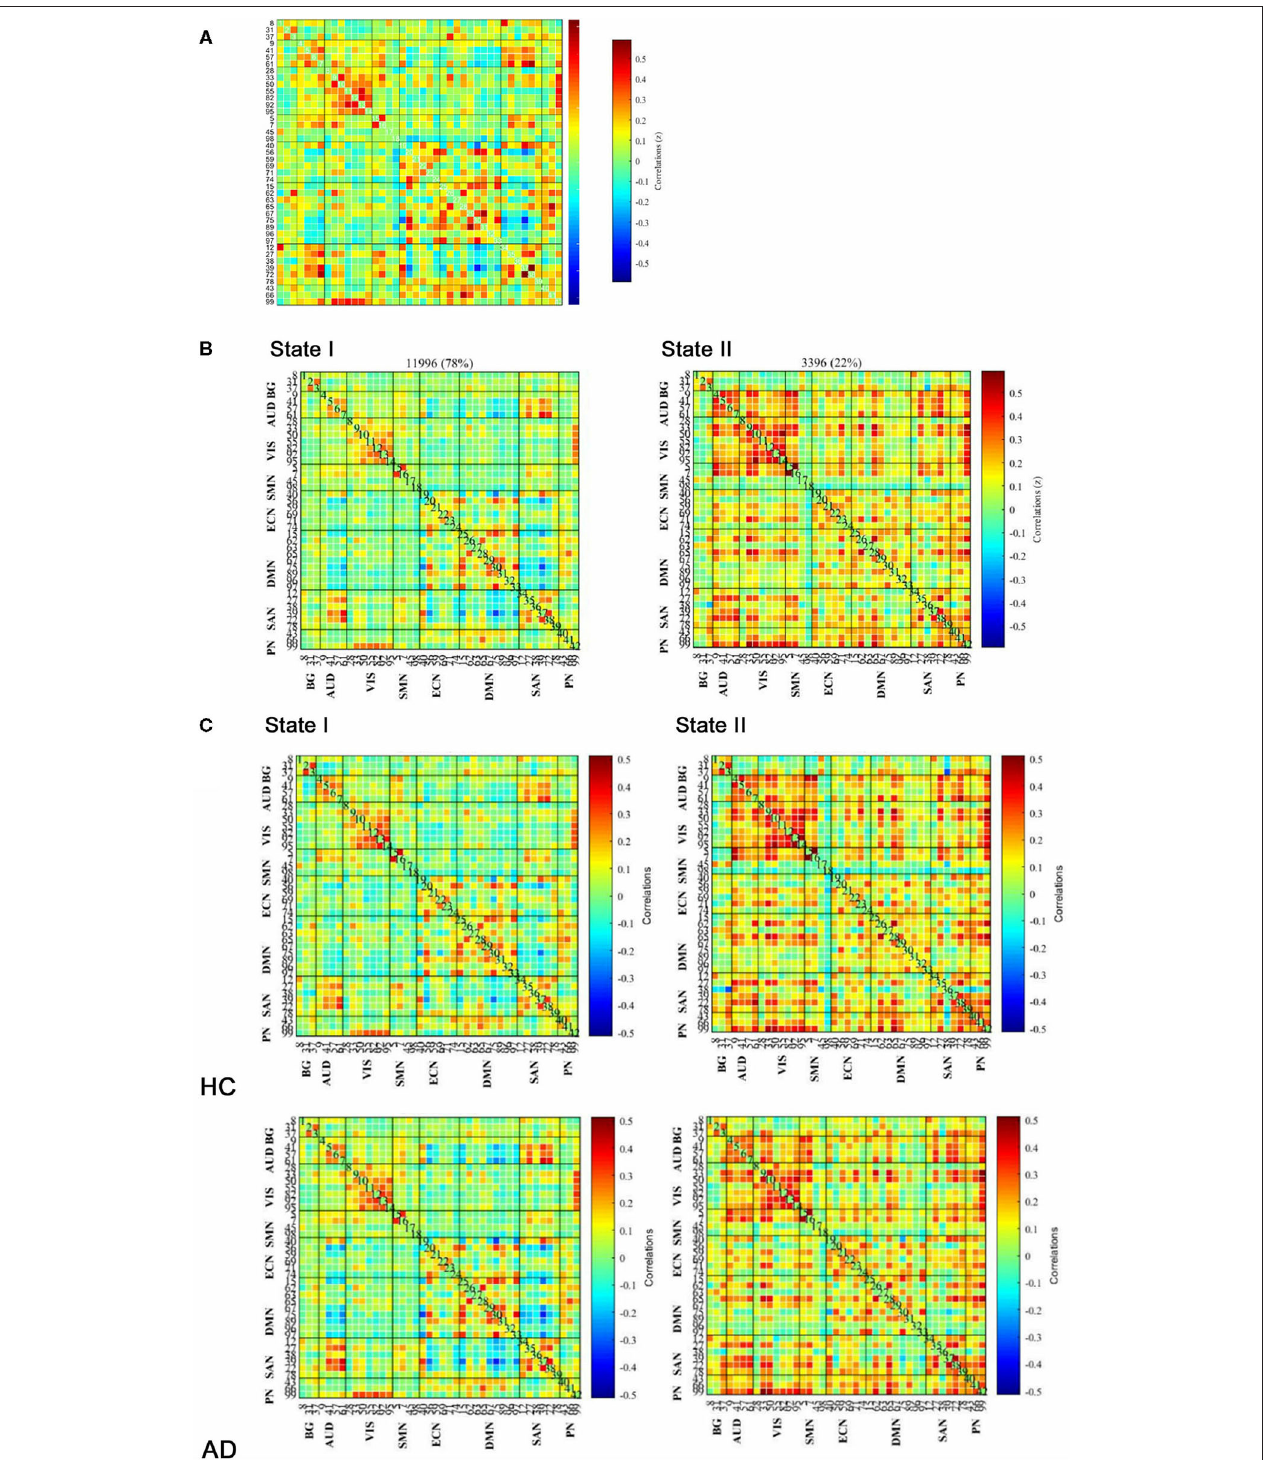
FIGURE 2 | Functional connectivity (FC) results. (A) Group-averaged static FC between IC pairs was computed using the entire resting-state data. (B) Results of the clustering analysis for each state. The total number of occurrences and the percentage of total occurrences are listed for each state. (C) Group centroid matrices and group-averaged across subject-specific median cluster centroids of each group [the percentage of total occurrences for states I and II: 68.20 and 31.80% in the healthy controls (HCs) and 83.21 and 16.79% in the anxiety disorder (AD) groups, respectively]. The value in the correlation matrix represents the Fisher’s z-transformed Pearson’s correlation coefficient. Based on 8 functional networks, 42 ICs were rearranged individually.